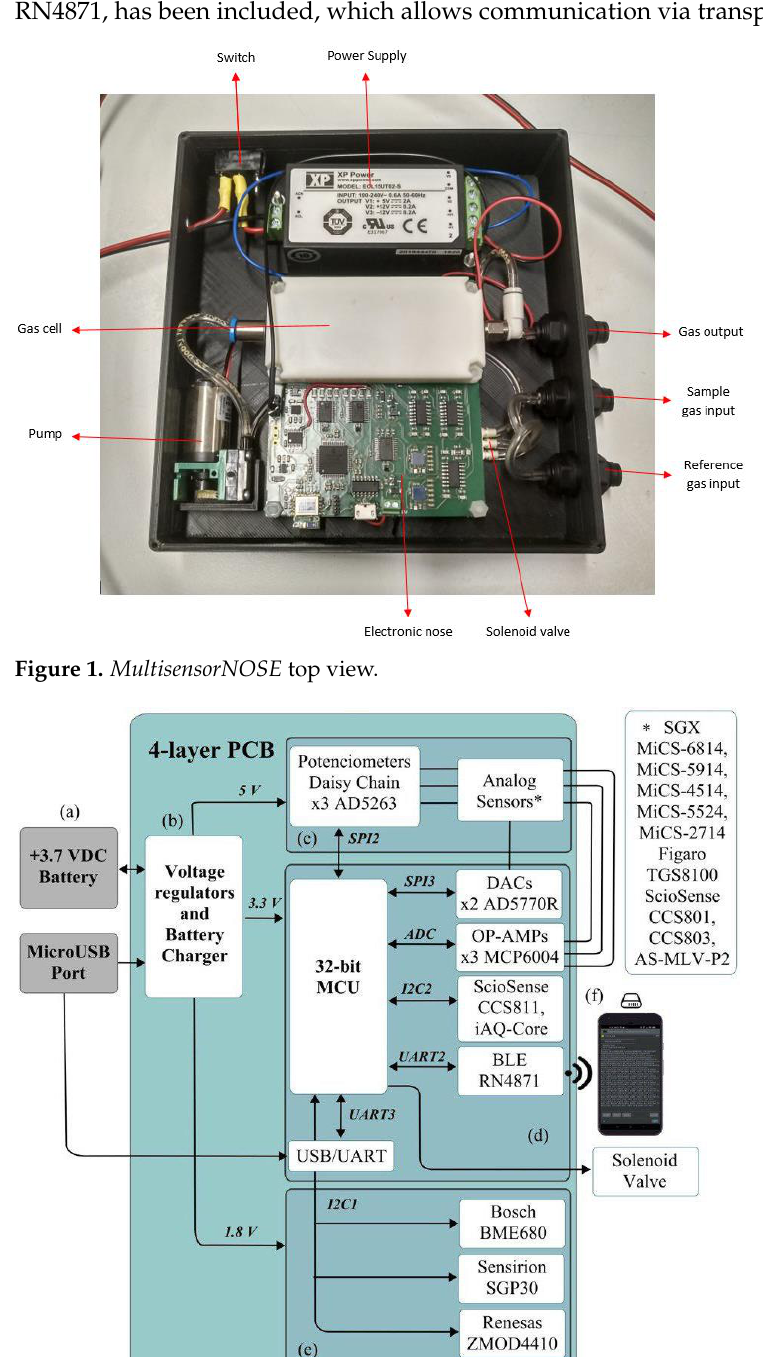
Figure 2. MultisensorNOSE block diagram. External battery (a); Voltage regulators and Battery Charger (b); 5 V DC components (c); 3.3 V DC components (d); 1.8 V DC components (e); Smartphone connected via Bluetooth (f).